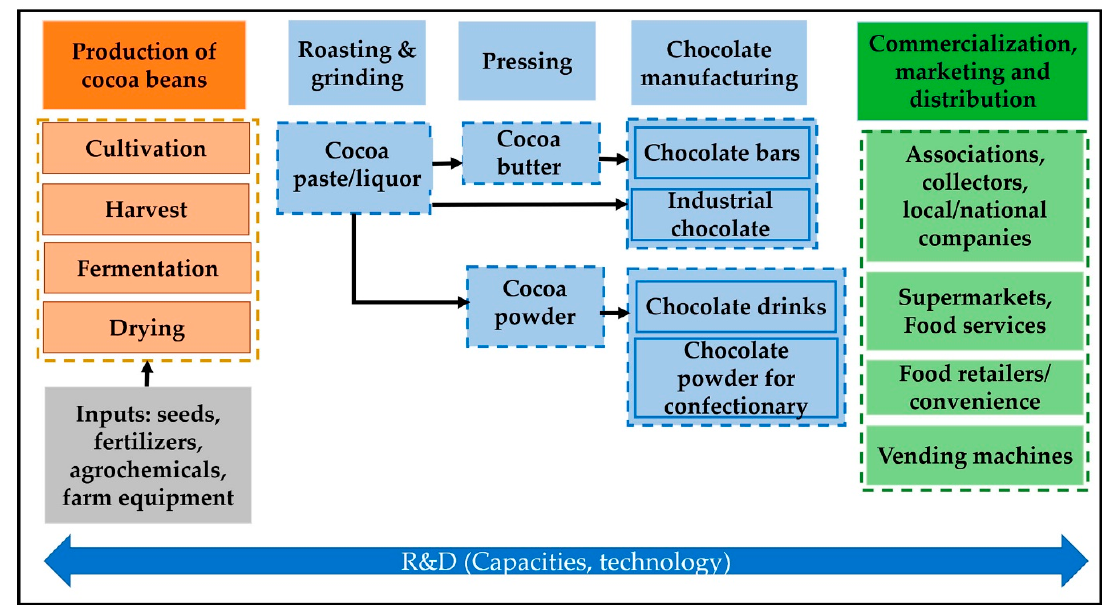
Figure 3. Main segments of the Colombian cocoa value chain and their activities.